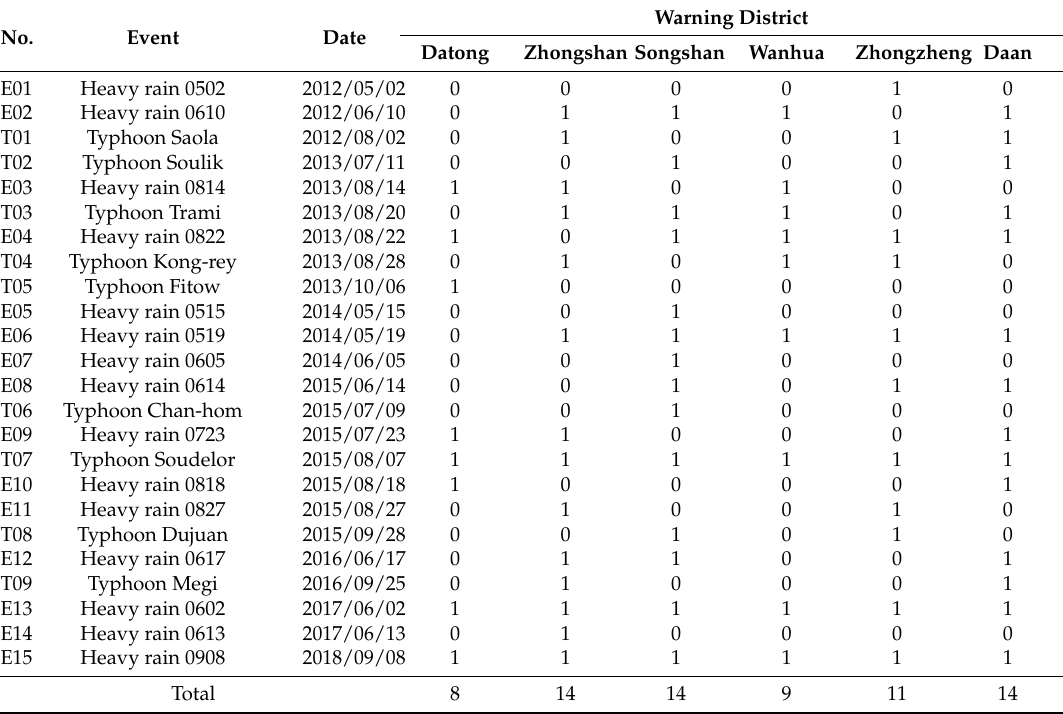
Table 2. Historical flood events for central Taipei from 2012 to